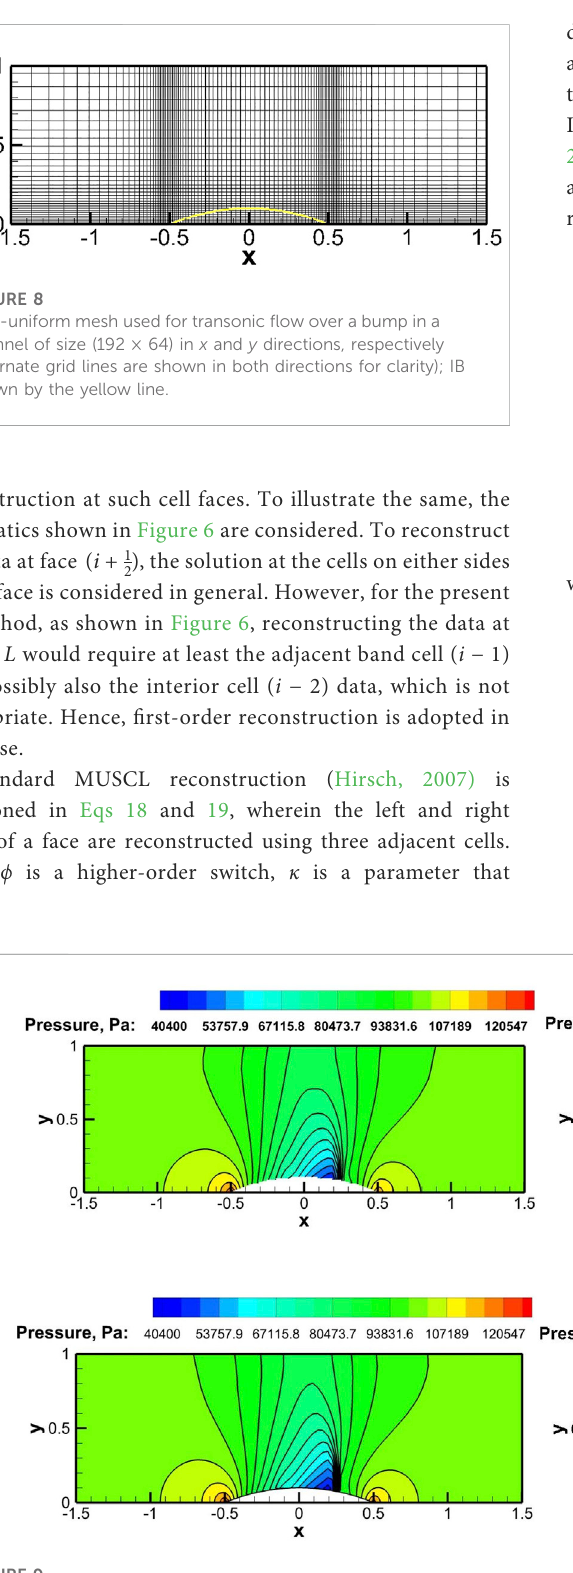
FIGURE 9 Pressurecontourcomparisonfortransonic fl owoverabumpusingthepresentIBMandIBM(A).ThepresentIBM(top)andIBM(A)(bottom);grid size: 130 × 42 (left) and 180 × 64